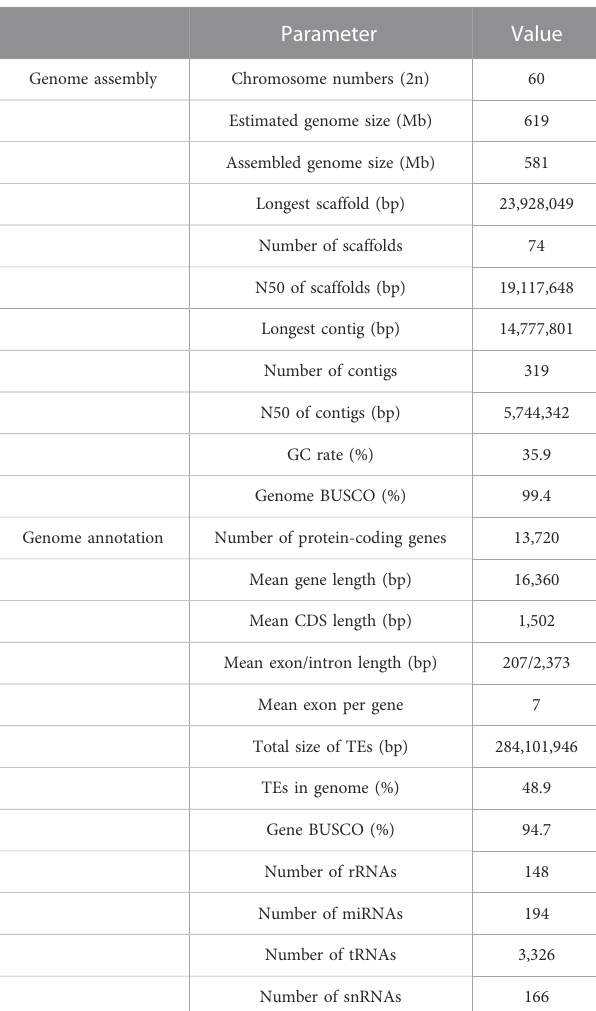
TABLE 2 Assessment of the de novo assembly and protein-coding gene annotation of S. montelus